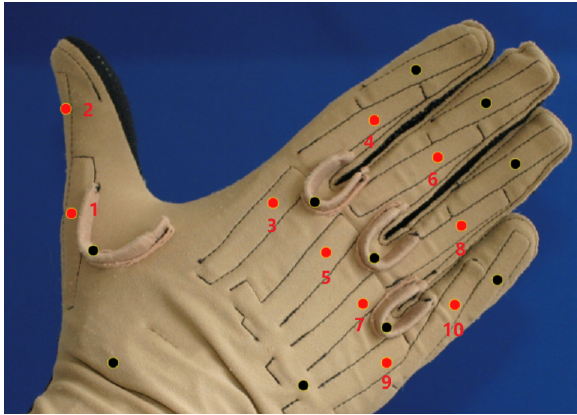
Figure 2. The 10 joint angles we selected for